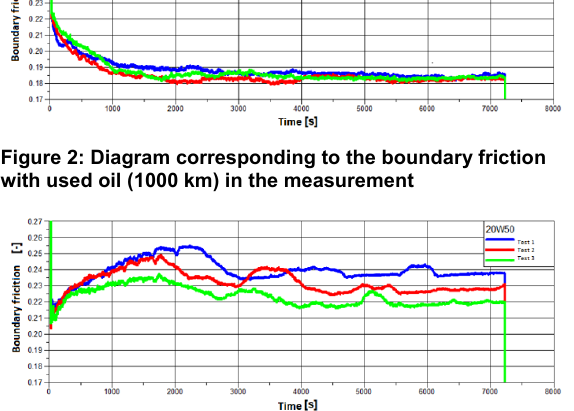
Figure 3: Diagram corresponding to the boundary friction with brand new oil (0 km) in the measurement